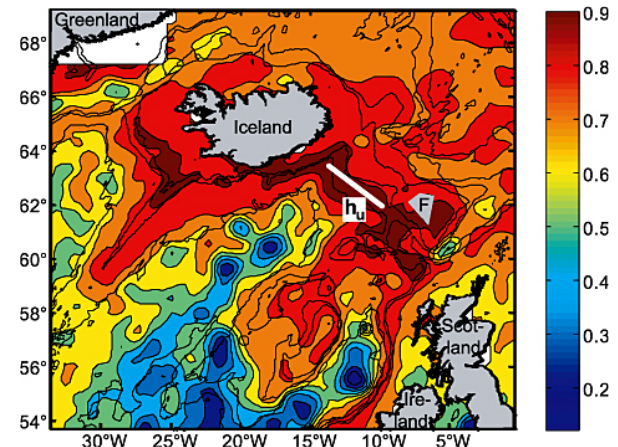
Fig. 7. Correlation coefficients between monthly averaged SLH on the white line ( h u ) and SLH in altimeter grid